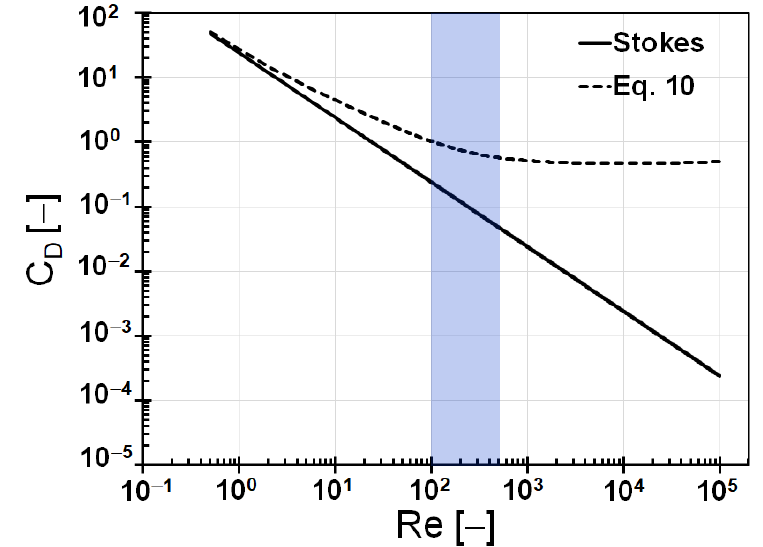
Figure A2. Comparison of the empirical drag coefficient used in the current analysis, given by Equation (10), with the Stokesian drag coefficient, C D = 24/ Re as a function of Re . The range of Re (100–500), which is explored in the ongoing experimental investigations of droplet grouping, is highlighted by the rectangular